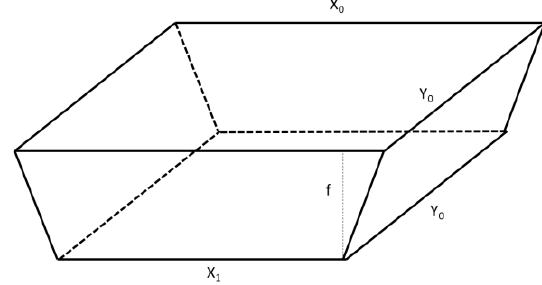
Figure A2. the pond geometrical representation. Figure A2. The pond geometrical